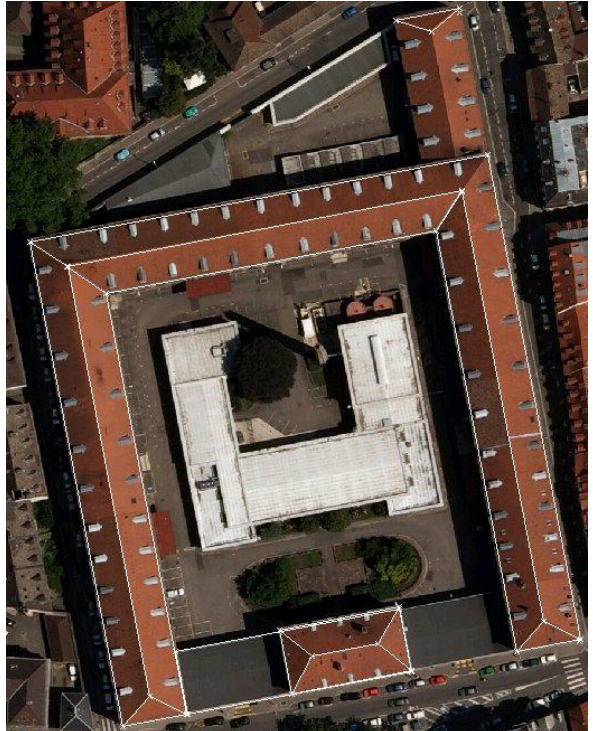
Figure 8. Wireframes of optimized model on the image which doesn’t involve in optimization